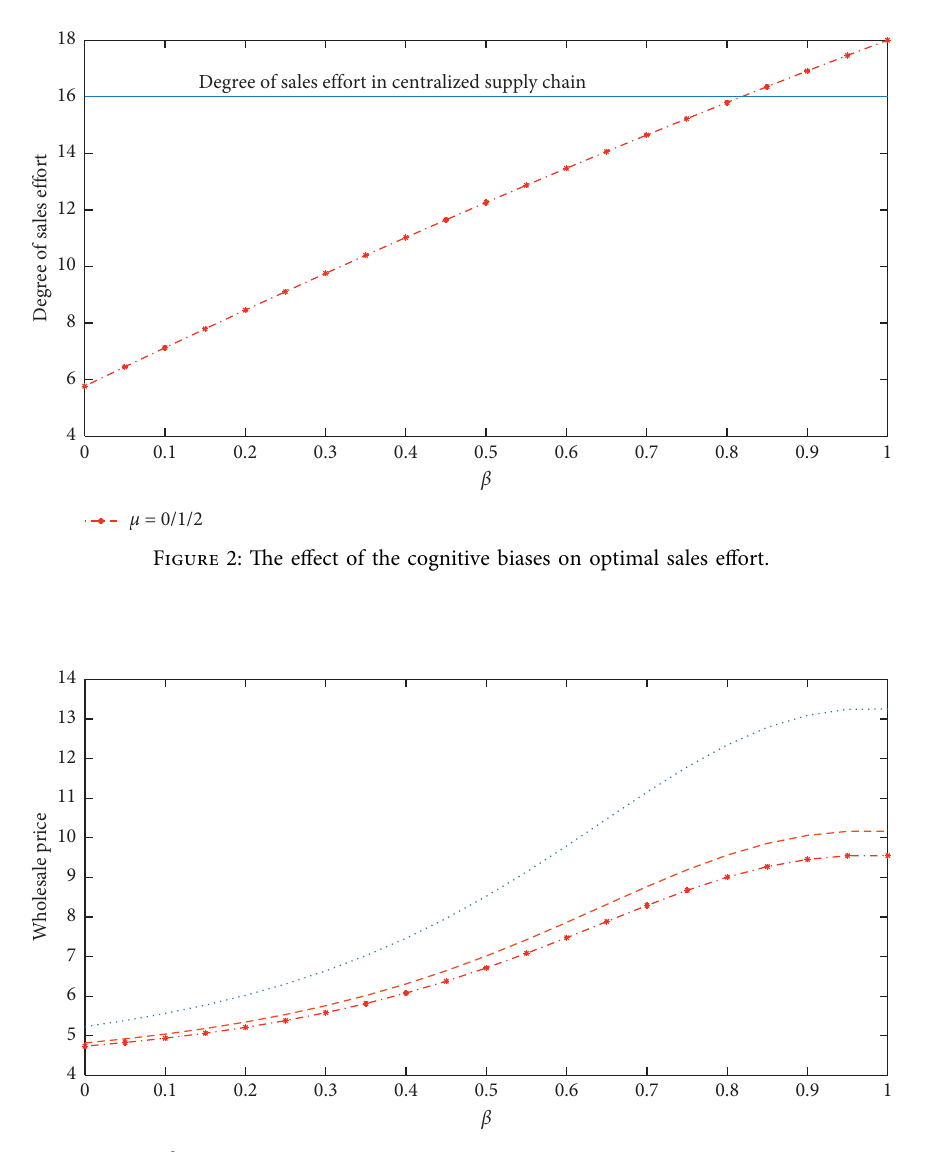
Table 1. For clearly analyzing the effect of β and μ on w sr ∗